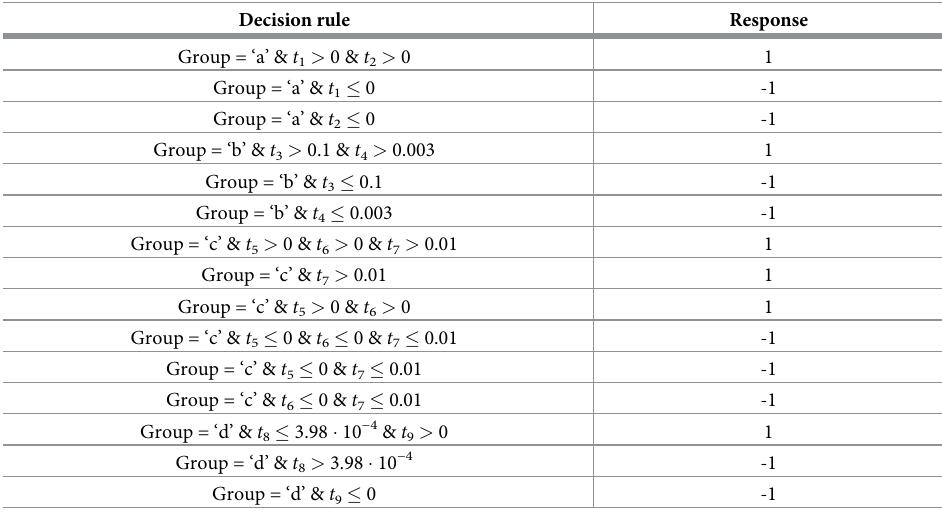
Table 1. Predetermined decision rules based on the making of the artificial